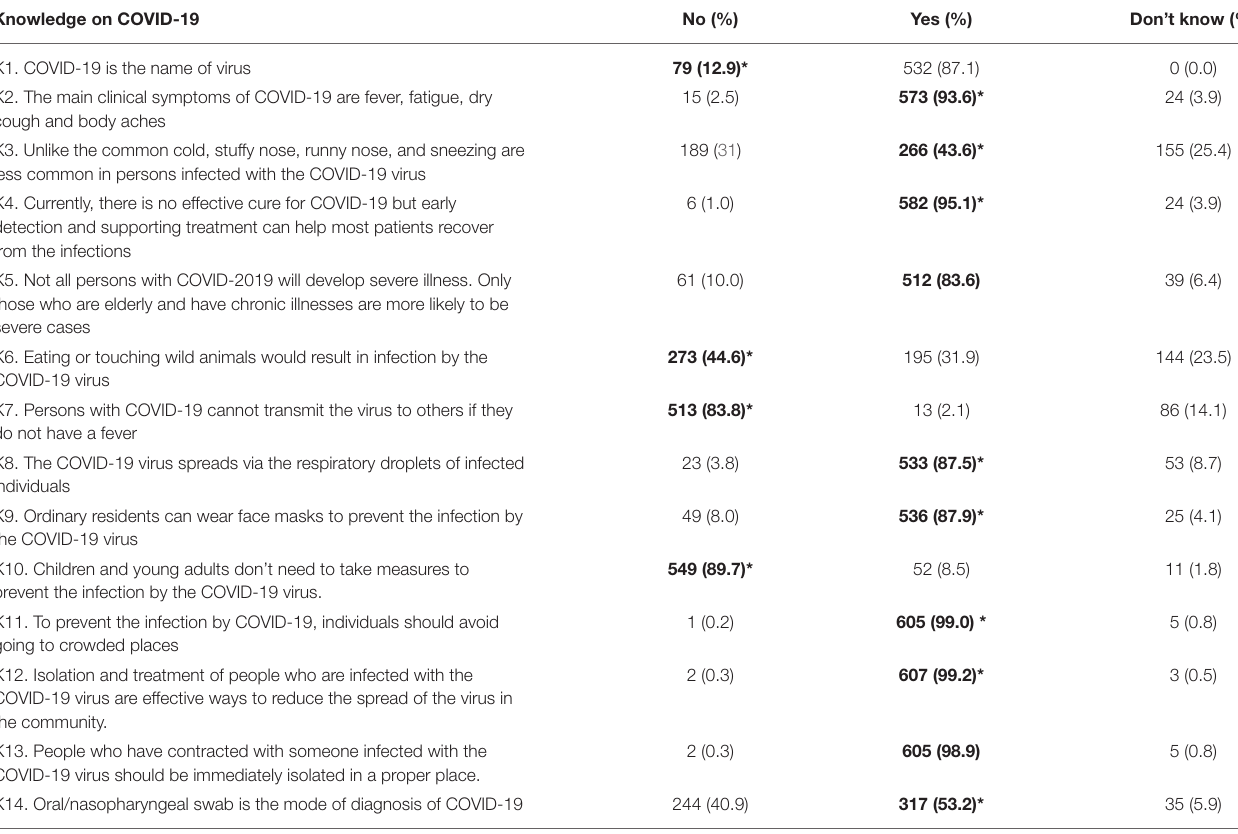
TABLE 2 | Knowledge on the coronavirus disease 2019 (COVID-19) among the Sherubtse College students. Knowledge on